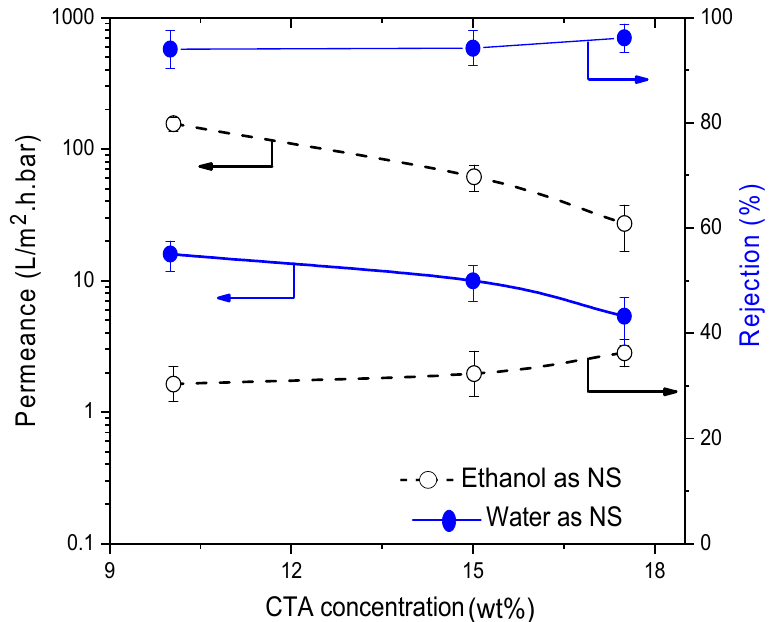
Figure 6. Influence of cellulose triacetate (CTA) concentration on membrane performance in terms of RB rejection and permeance. Striped lines represent membranes prepared using ethanol as non-solvent and full lines those with water as non-solvent.